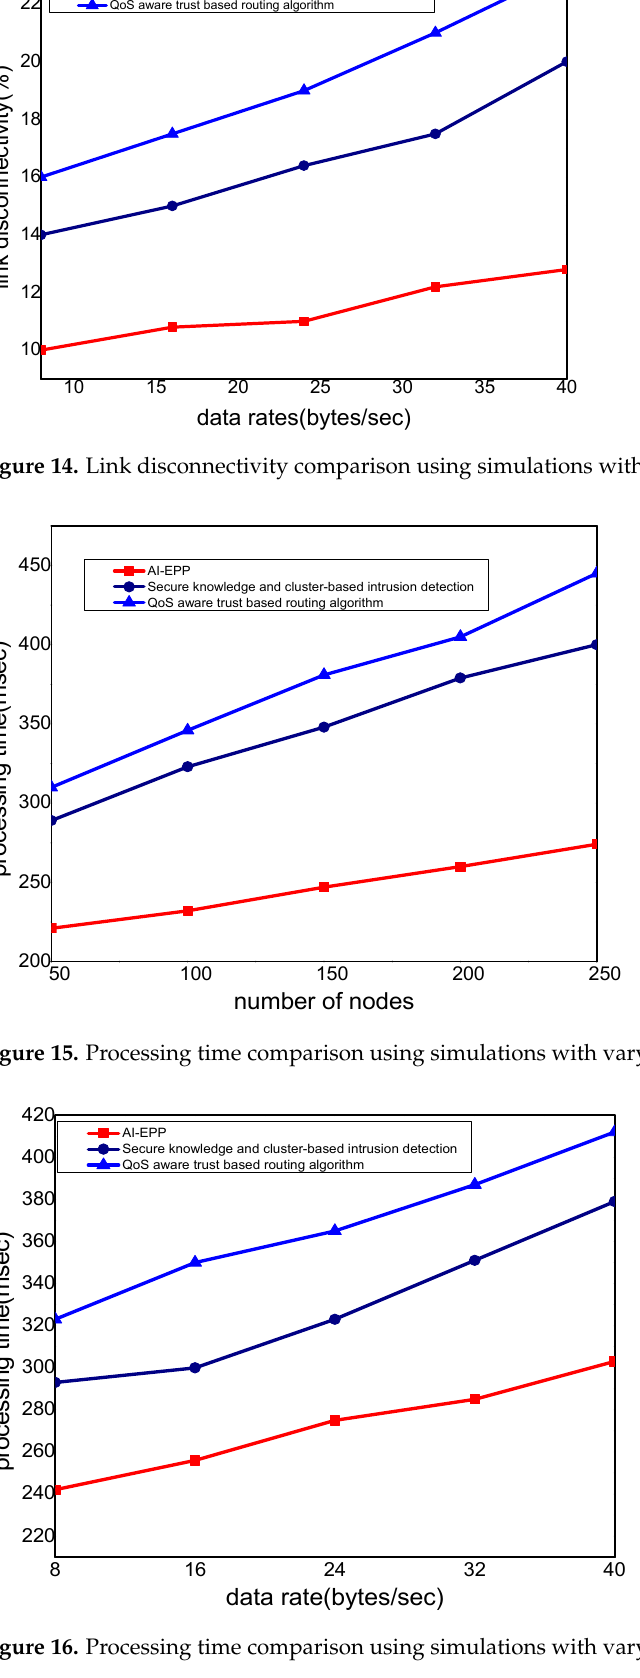
Figure 16. Processing time comparison using simulations with varying data rates.